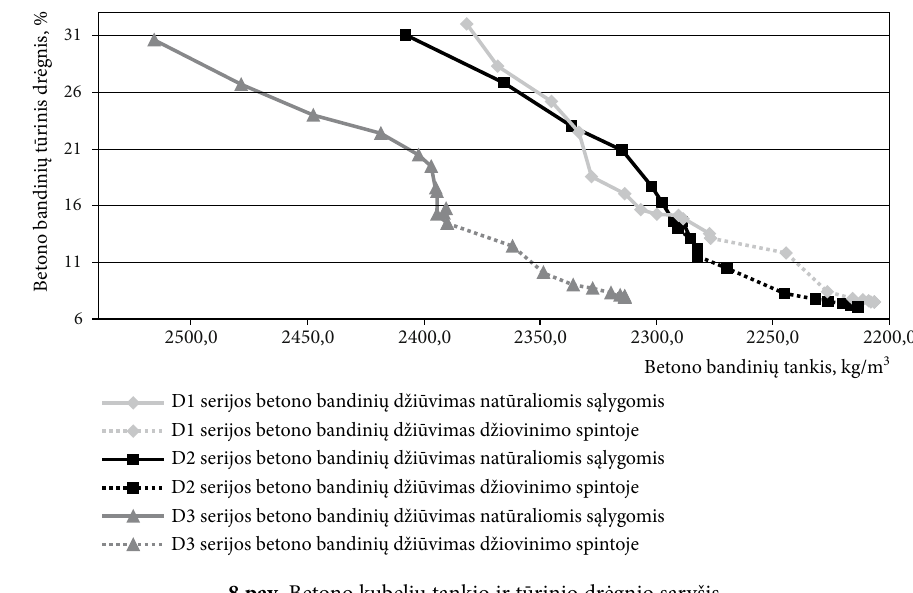
Fig. 8 . The relation between bulk moisture and concrete cube density